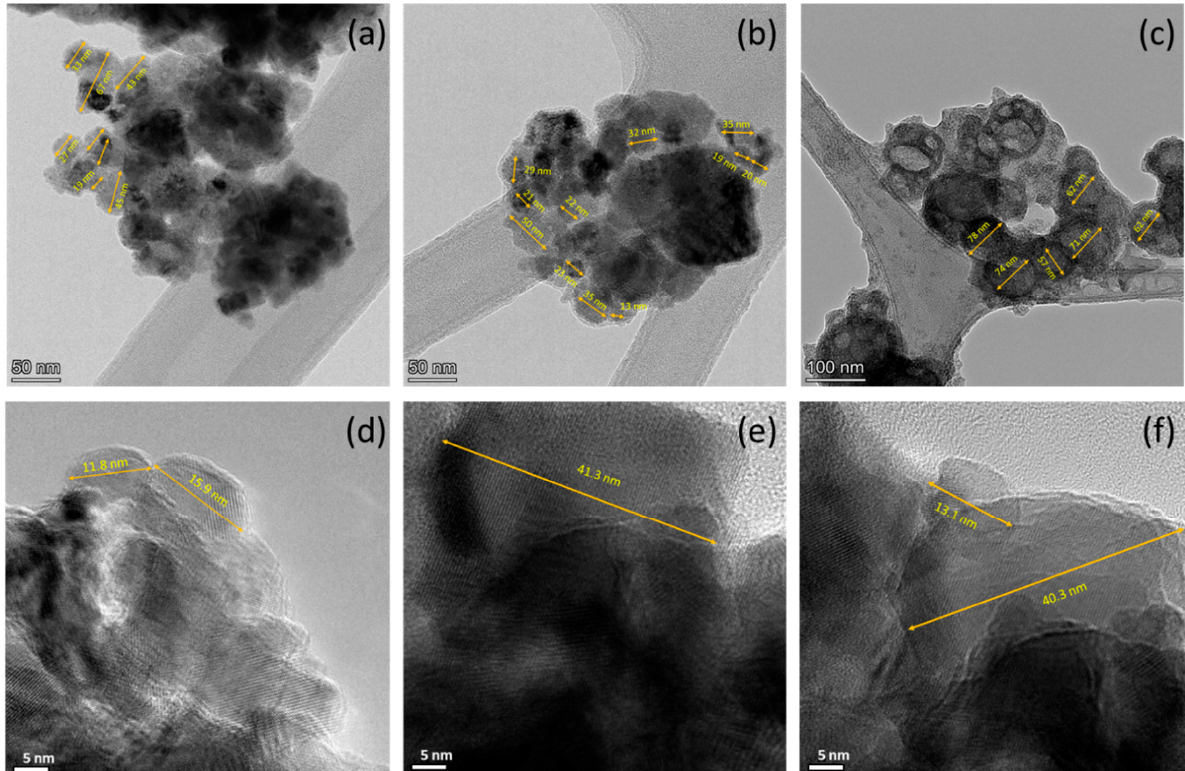
Figure 4. High-magnification TEM micrographs of ( a , b ) OMO(0), ( c ) OMO(5), and ( d – f ) OMO(40) corresponding to different resolutions. The sizes of some selected nanoparticles are marked on the image.